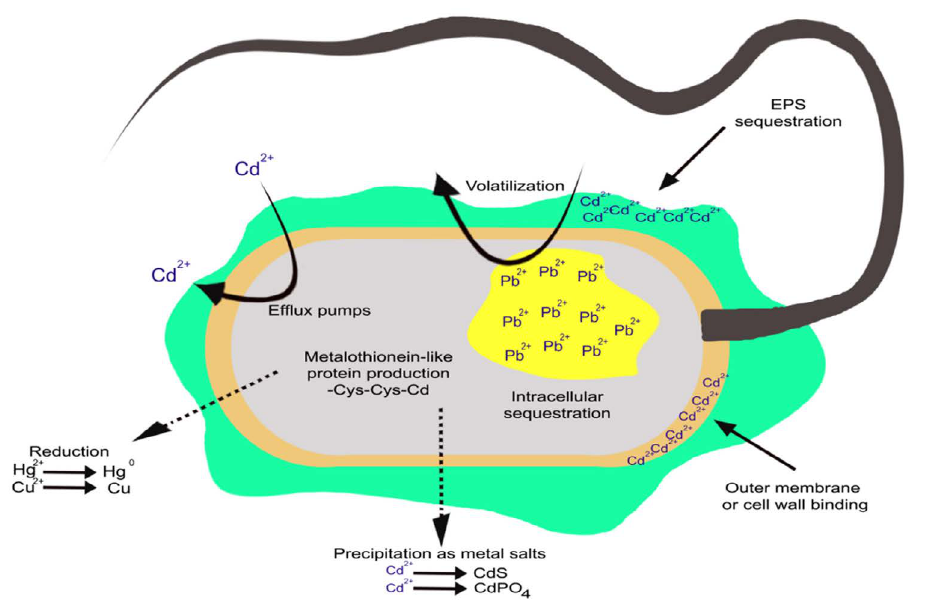
Fig. 1 . Mechanisms (intracellular and extracellular) developed by microorganisms to resist and detoxify harmful heavy